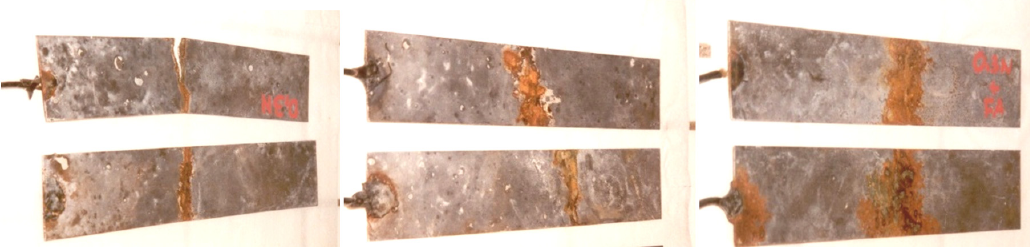
Figure 7. Visual observation of the corrosive attack on the bare steel plates in reference natural aggregate concrete (Nat-0.6, on the left), in recycled aggregate concrete (Rec-0.3, in the middle), and high-volume fly ash concrete (Nat + FA-0.6, on the right).